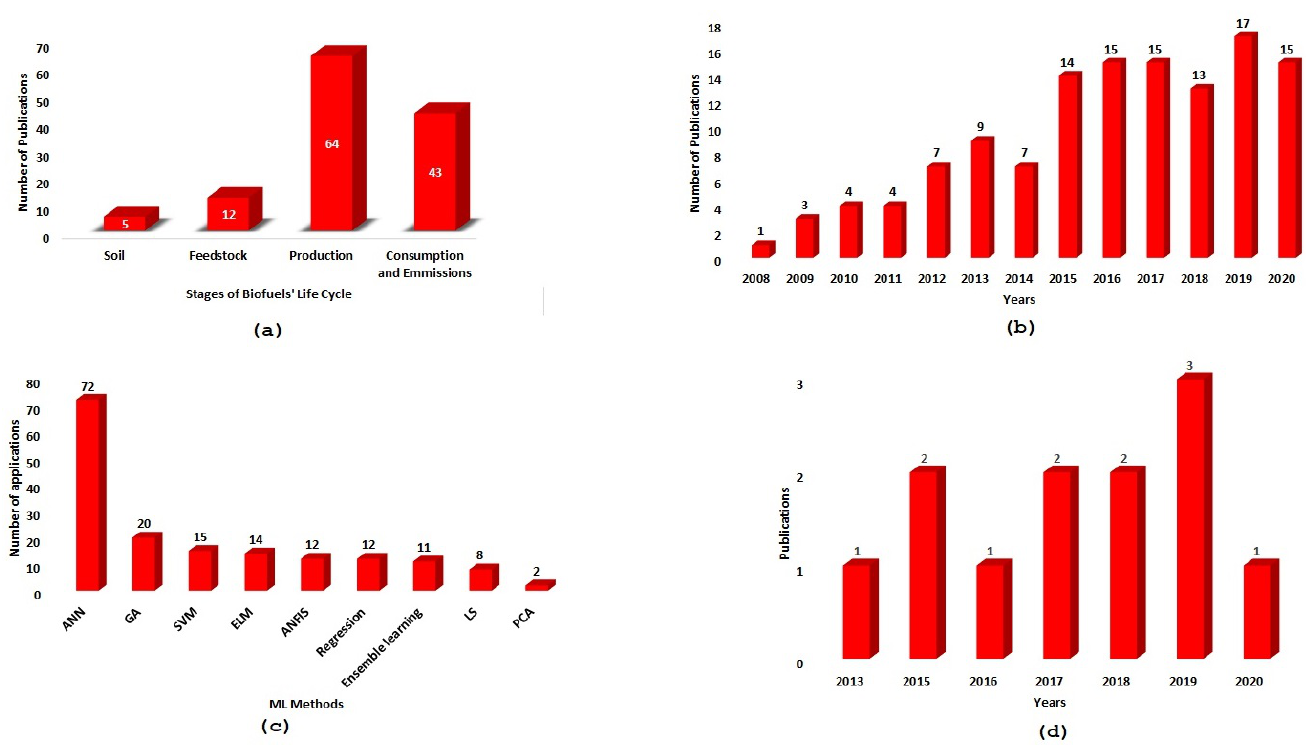
Figure 2. ( a ) Stage-wise share of publications, ( b ) Year-wise publications in the subject area, ( c ) ML method-wise publications, and ( d ) Year-wise publication from the second generation ML methods.